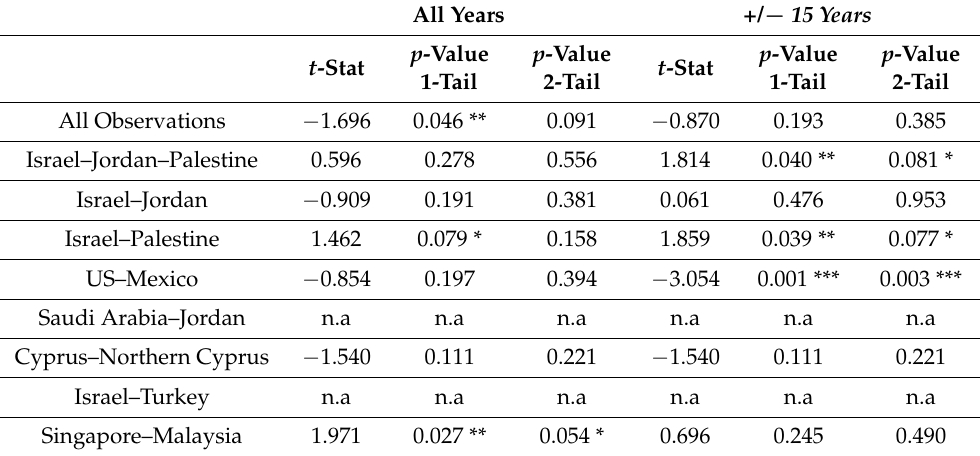
Table 4. Summary of one-tailed and two-tailed t